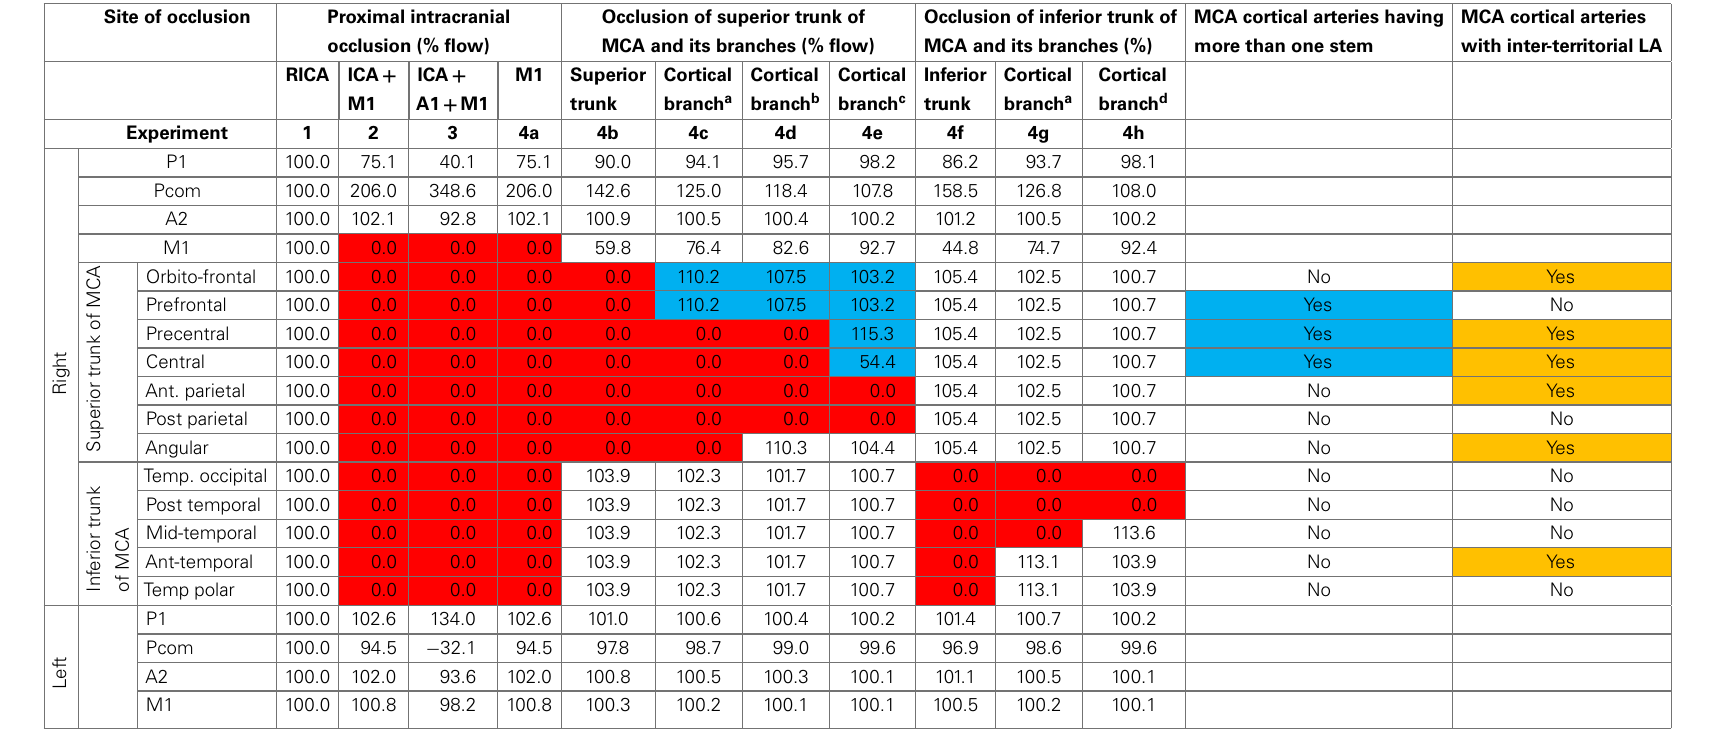
Table 1 | Effect of experimental arterial occlusion on flow in the right MCA territory (no LA) . Site of